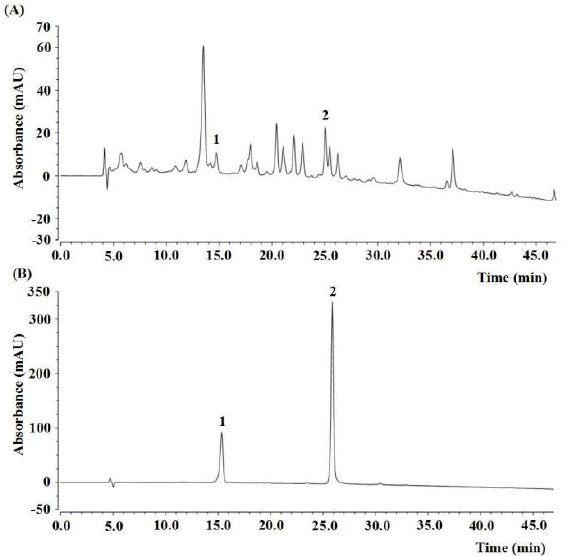
Figure 2. HPLC chromatogram of the ethyl acetate fraction of Physalis alkekengi . ( A ) HPLC analysis of PAE, and ( B ) external standard. The peak 1, rutin (t’ R = 10.32 min); peak 2, luteolin (t’ R = 20.84 min).